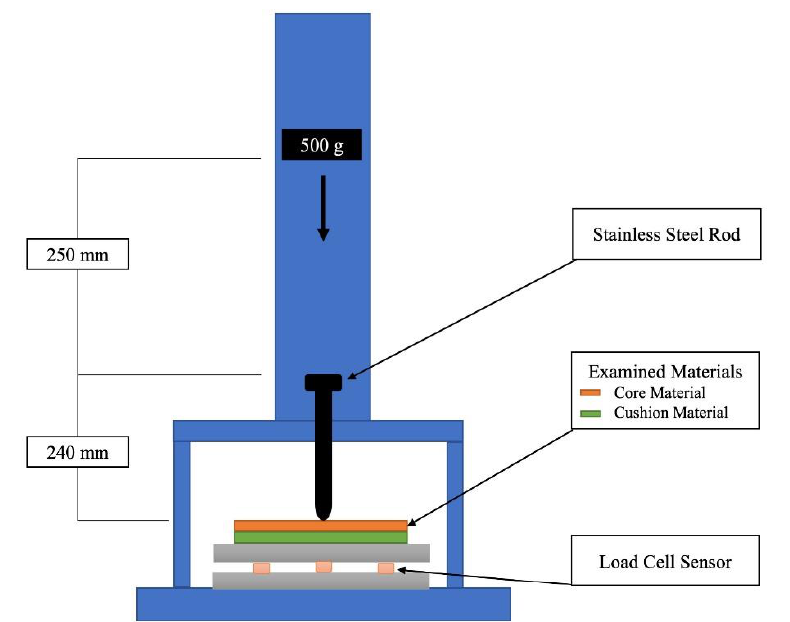
Figure 3. Schematic diagram of setup for shock absorption test.